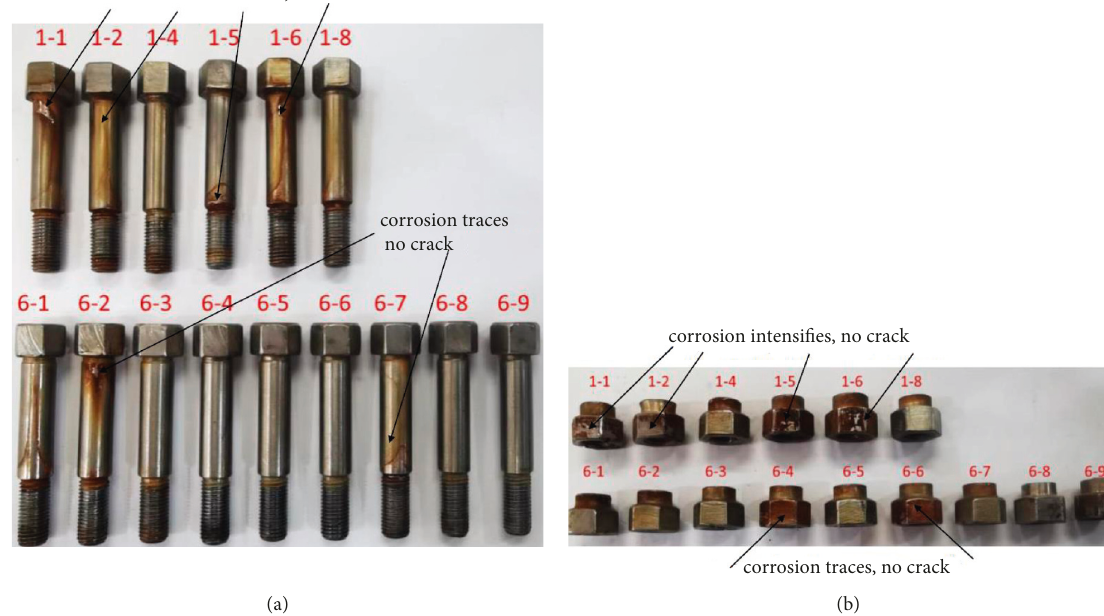
Figure 8: The status of the test piece after the second stress corrosion test. (a) The state of the bolt after the test. (b) The state of the nut after the test.